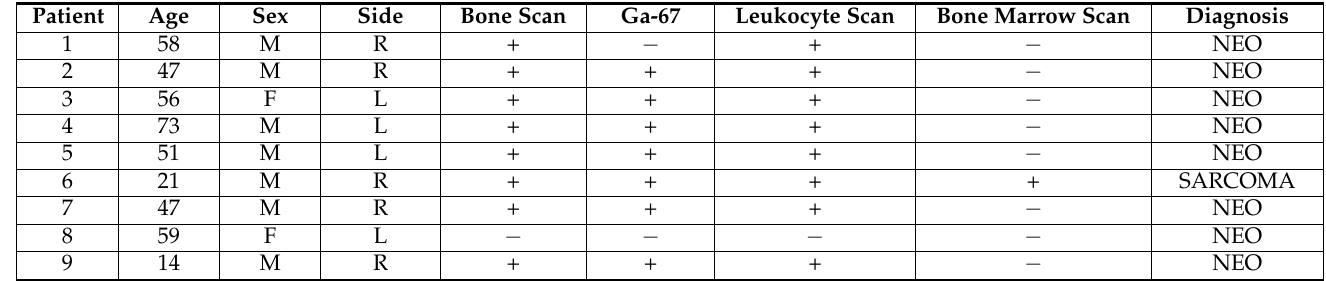
Table 1. Comparative results of the final